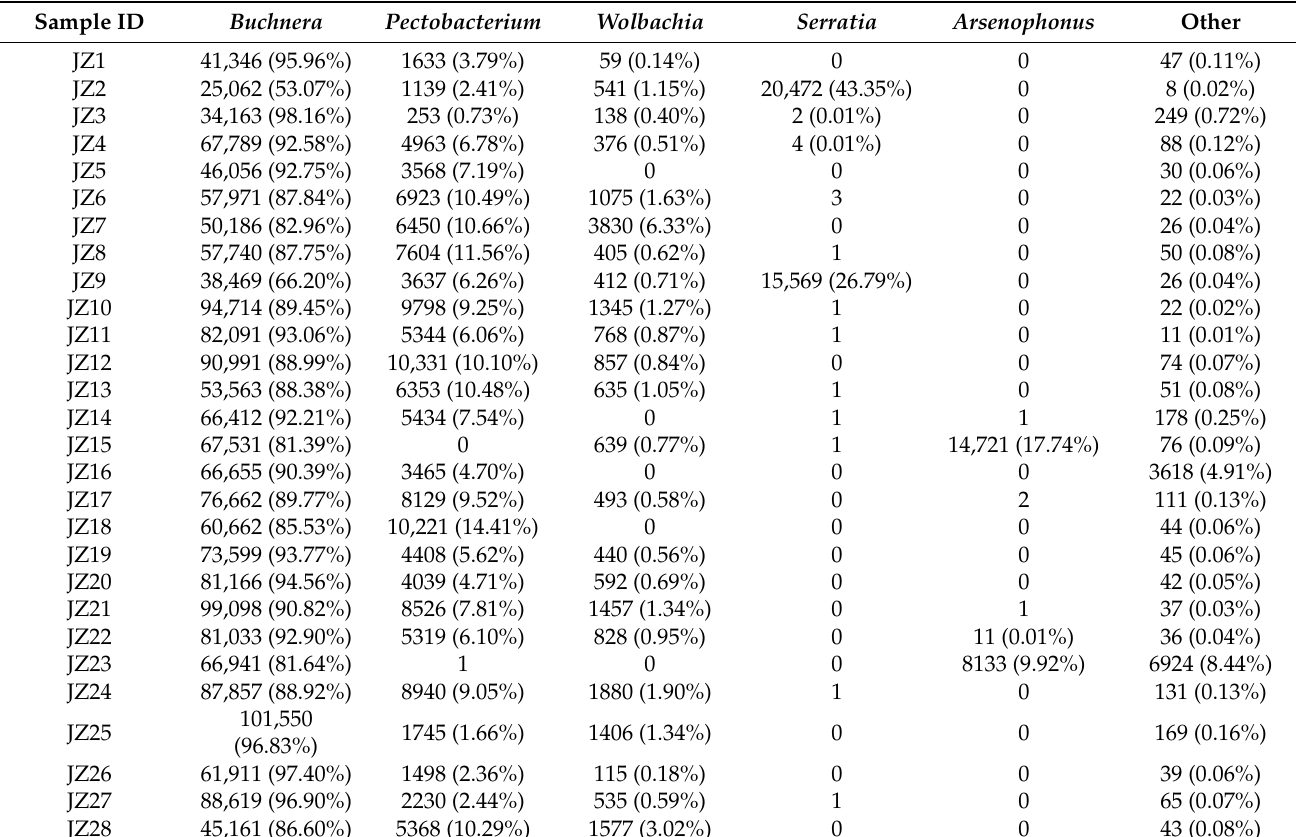
Table 3. Reads and relative abundance of symbiotic bacteria in each sample, emphasizing the major five